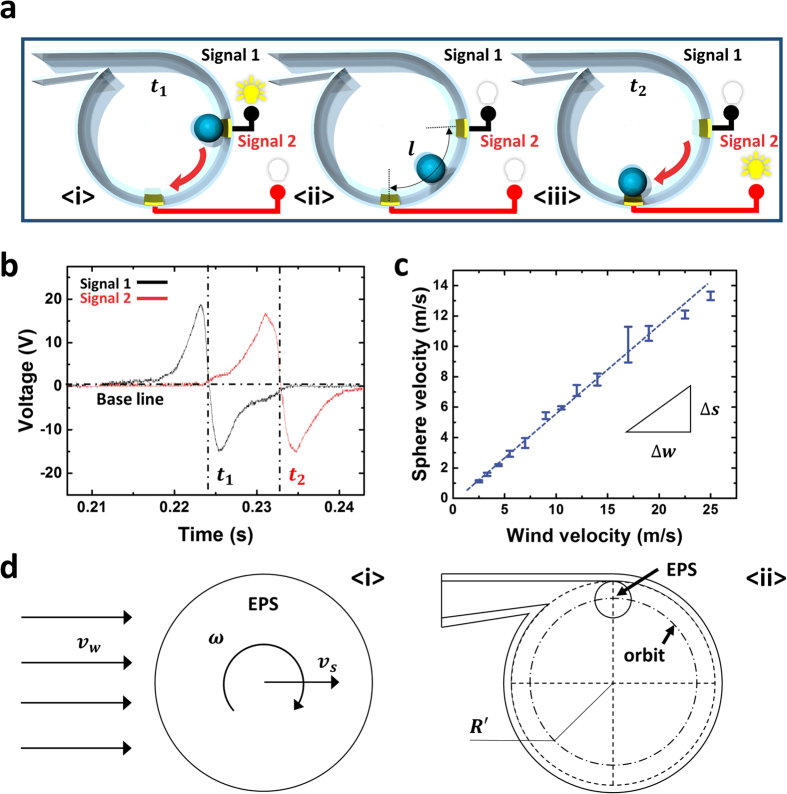
The WR-TENG used as a self-powered wind velocity sensor.(a) A schematic illustration of the WR-TENG wind velocity sensor. (b) The VOC output generated at points t1 and t2. (c) The relationship between the calculated sphere velocities and the measured wind velocities. (d) A simplified illustration and various parameters used to calculate the kinetic energy of the EPS sphere.